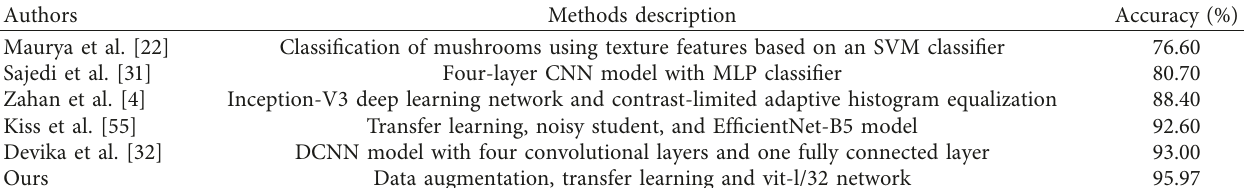
Table 4: Performance of the proposed method compared with other published methods for mushroom classification.